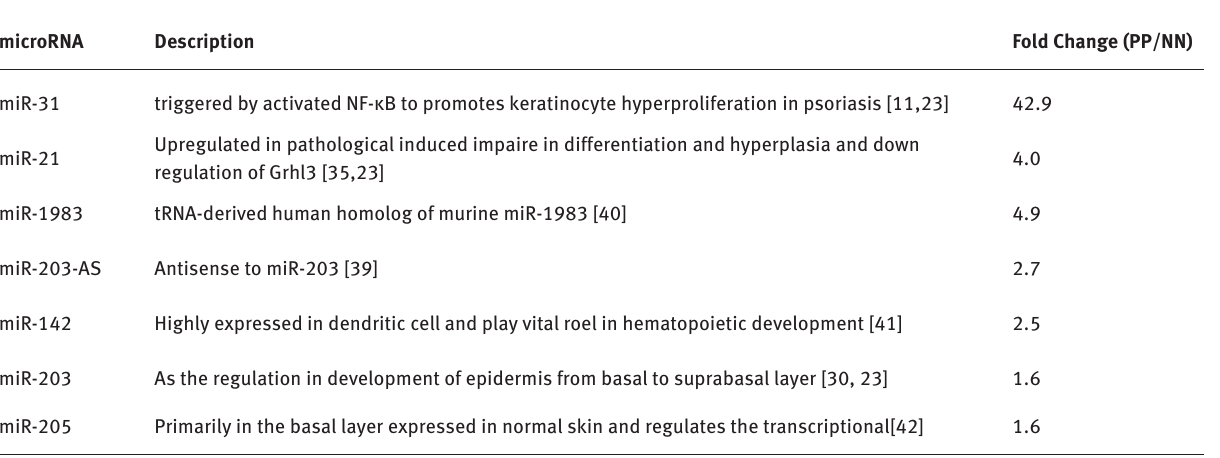
Table 2: Some of microRNAs that express aberrantly in human psoriatic skin